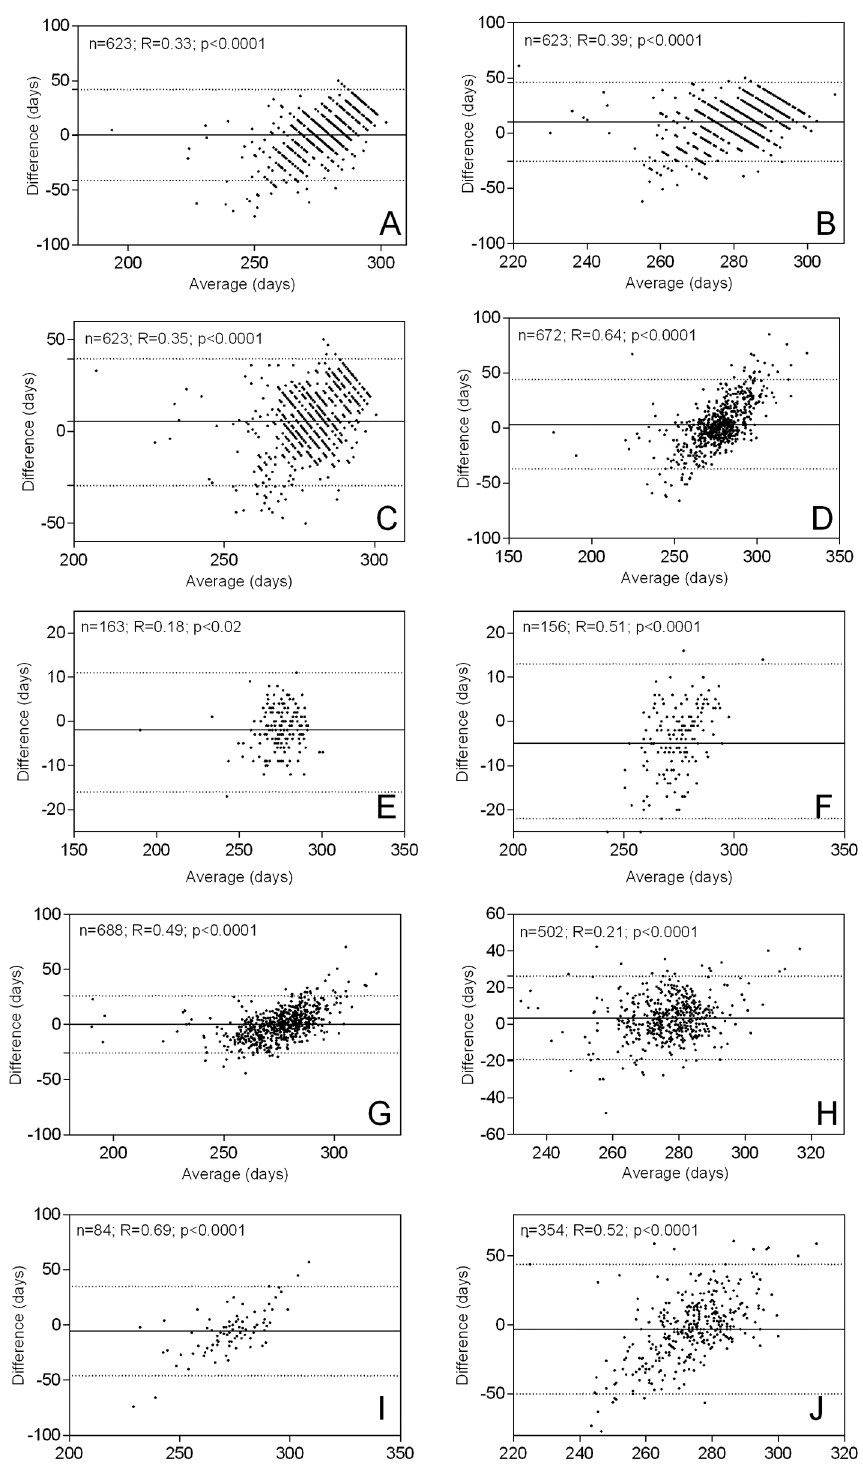
Fig 3. Bland-Altman Plots and Levels of Agreement. A) BS (external); B) BS (neuromuscular); C) BS (total); D) LMP; E) mid-pregnancy ultrasound; F) late-pregnancy ultrasound; G) linear SFH model; H) sequential SFH model; I) Quickening; J) corrected LMP * . The continuous horizontal lines are average